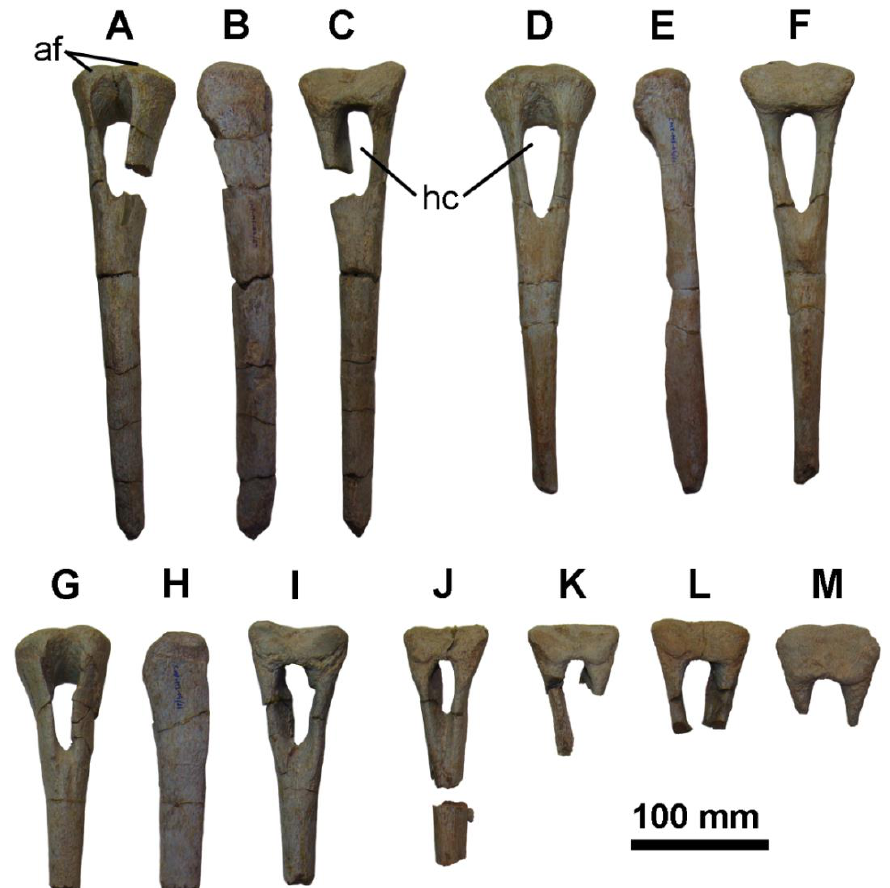
Figure 5. Haemal arches of the specimen CMP-MS-04. CMP-MS-04/09 in anterior ( A ), right lateral, ( B ), and posterior ( C ) views. CMP-MS-04/10 in anterior ( D ), right lateral, ( E ), and posterior ( F ) views. CMP-MS-04/11 in anterior ( G ), right lateral, ( H ), and posterior ( I ) views. CMP-MS-04/12-16 ( J ), CMP-MS-04/13 ( K ), CMP-MS-04/14 ( L ), and CMP-MS-04/15 ( M ) in posterior views. Abbreviations: af, articular facet; hc, haemal canal.